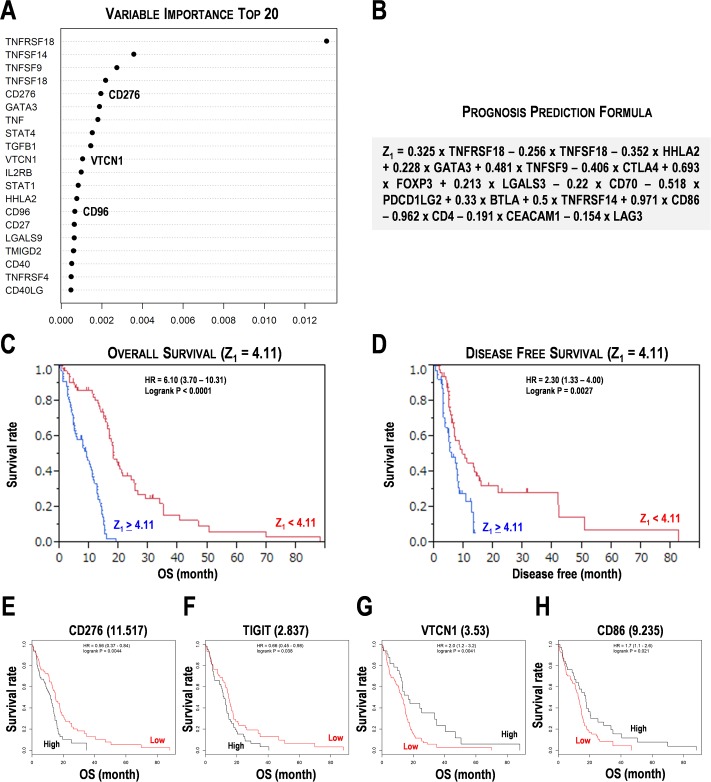
Prognostic marker candidates for cancer immunotherapy in the training data set of glioblastoma multiform (GBM).(A) Random survival forest analysis for cancer immunotherapy-related genes in GBM. Top 20 of variable importance was shown. (B) Prognosis prediction formula for cancer immunotherapy-related genes in GBM. The Z1 score is calculated by the expression values of 16 immunosuppressive pathway genes. (C,D) Kaplan-Meier survival analysis using the Z1 score = 4.11. (C) Overall survival analysis (OS). (D) Disease free survival analysis. HR, hazard ratio. (E-H) Kaplan-Meier survival analysis for representative immunosuppressive pathway genes in GBM. (E) CD276/B7-H3. (F) TIGIT. (G) VTCN1. (H) CD86. Numbers in the parentheses indicate the threshold of gene expression. High and low indicate subgroups with over and under the threshold. OS, overall survival. HR, hazard ratio. Subgroups were divided by the median score of Z1 and the median expression of genes.